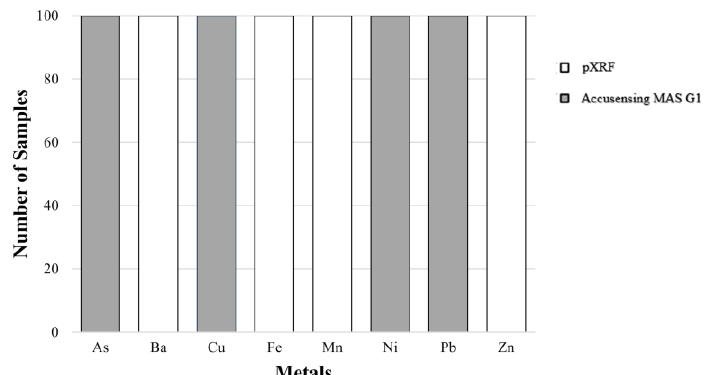
Figure 2. Analysis of HMMs using Accusensing MAS G1 and pXRF.